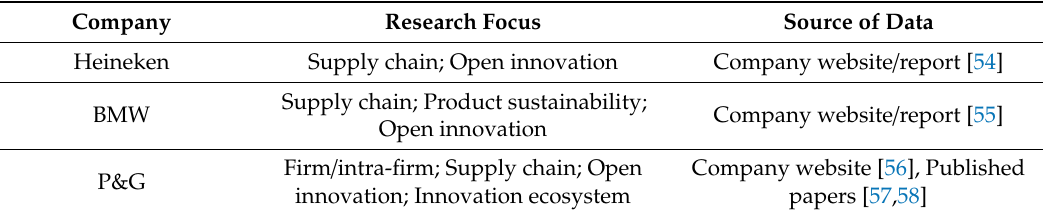
Table 1. Case company